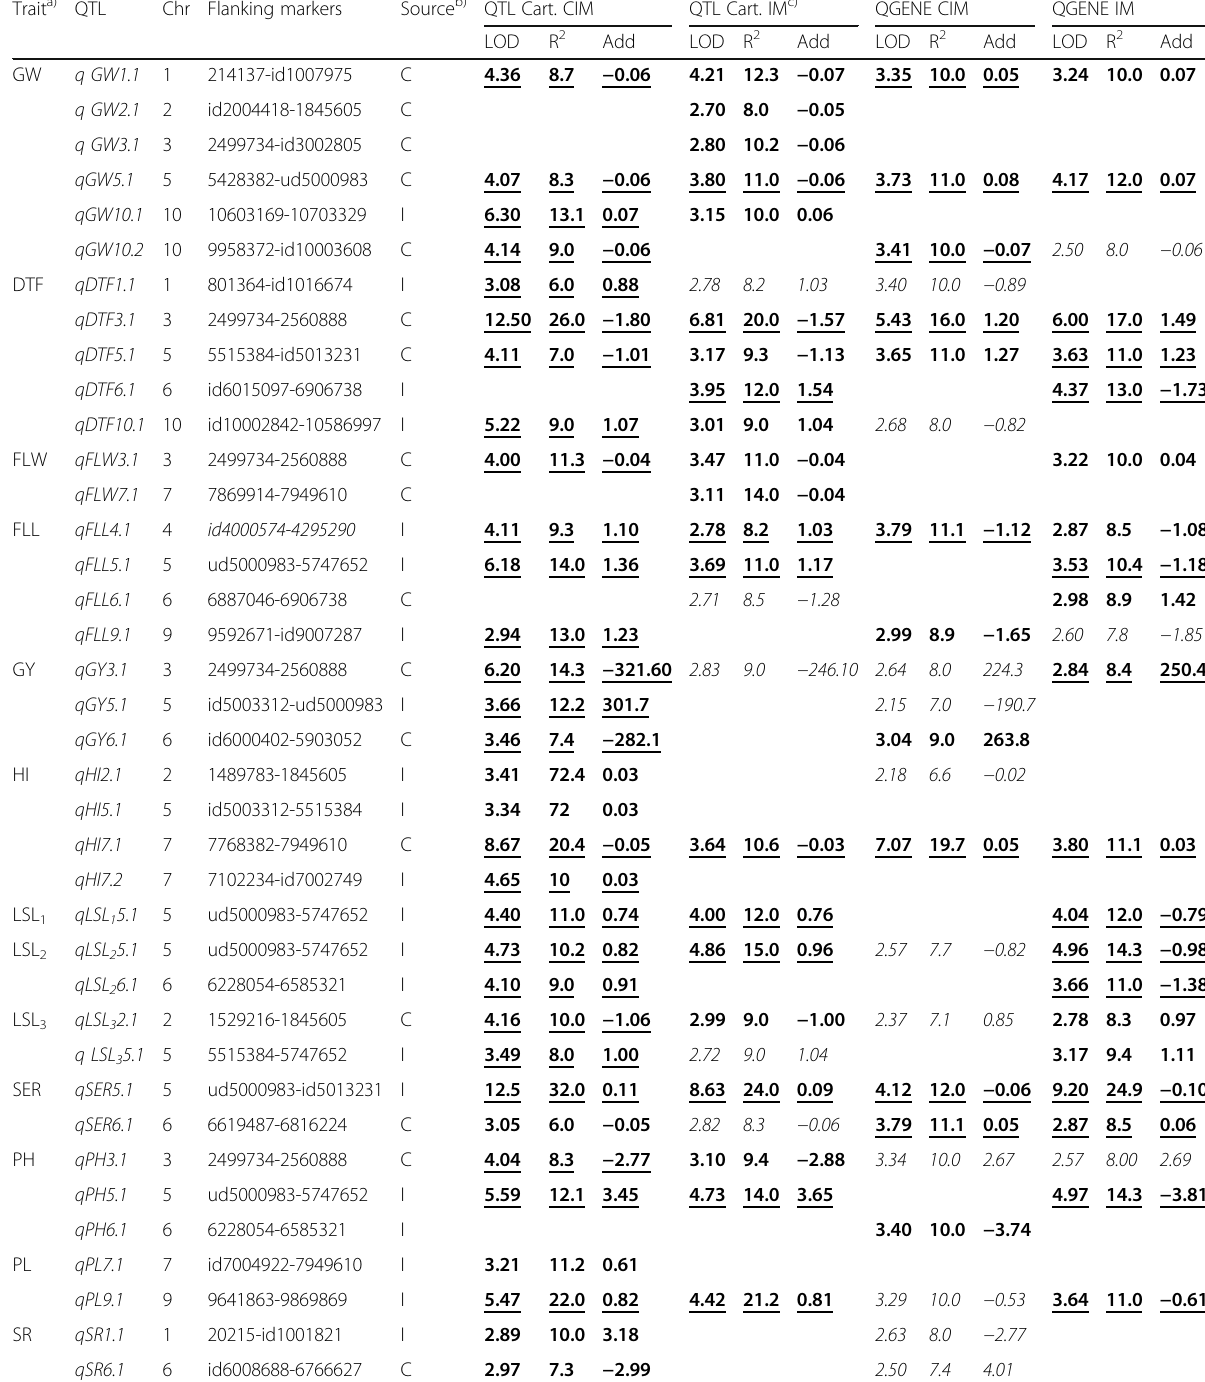
Table 3 QTLs for yield in agronomic traits from a RIL population of Ciherang-Sub1/IR10F365 identified under stagnant flooding condition Trait a)